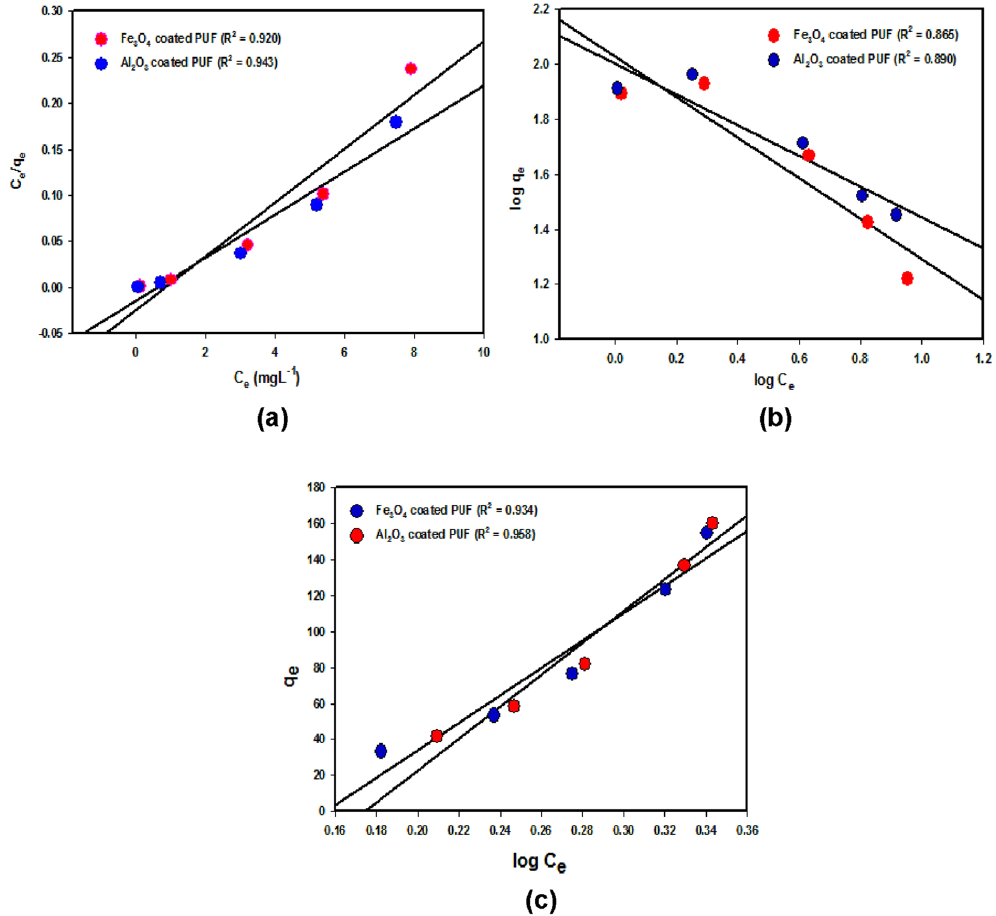
Figure 5. Adsorption isotherms on Al 2 O 3 and Fe 3 O 4 NPs-PUF. ( a ) Langmuir plot, ( b ) Freundlich plot and ( c ) Temkin